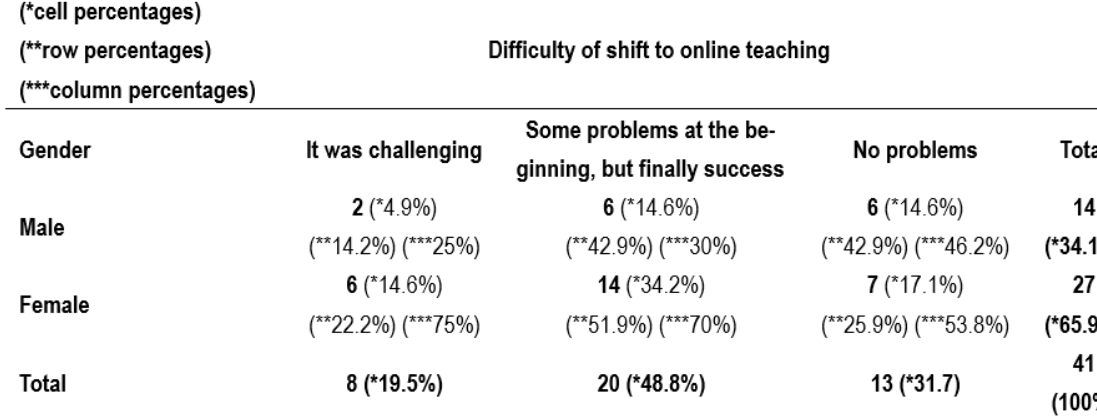
The success of shift to online education depending on gender